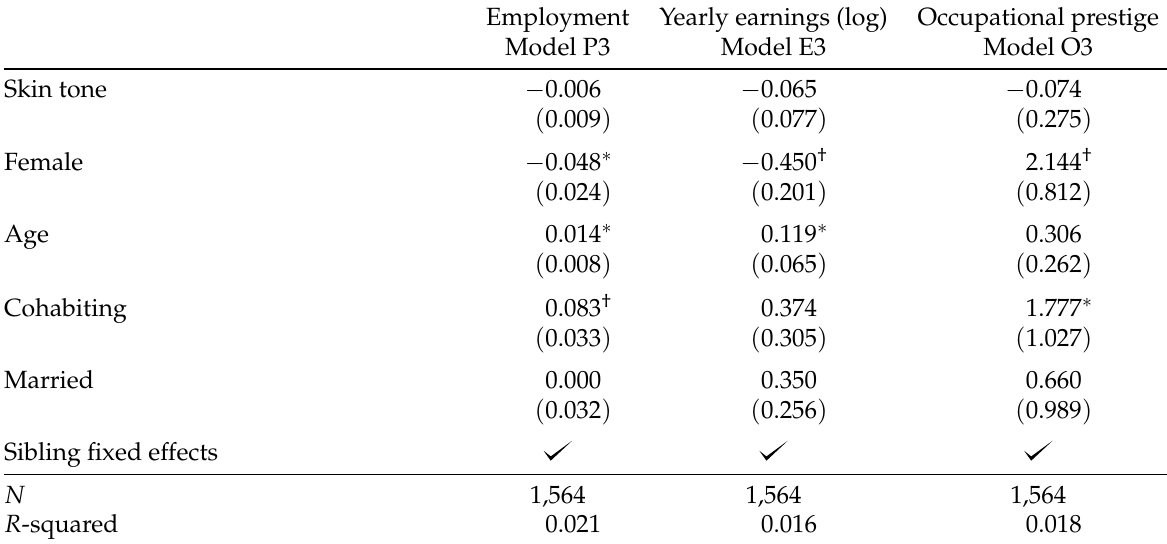
Table 2: Labor market outcomes by skin tone, covariates, sibling fixed effects: Blacks and Latinos with full or half siblings in